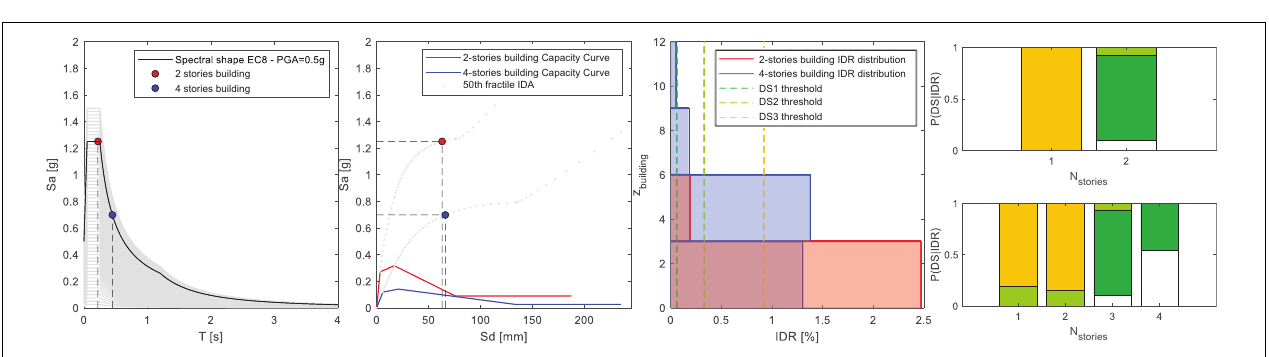
FIGURE 12 | Comparison between GLD-2 (red) and GLD-4 (blue) being equal the PGA demand (PGA = 0.5